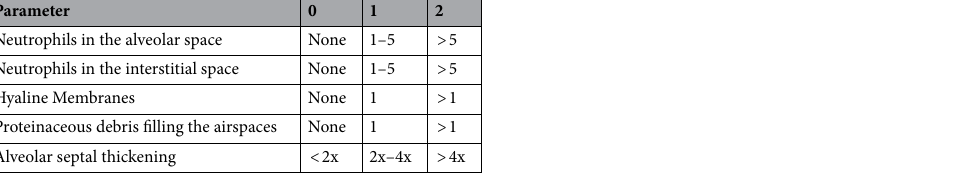
Table 2. Histopathological human lung injury scoring system.